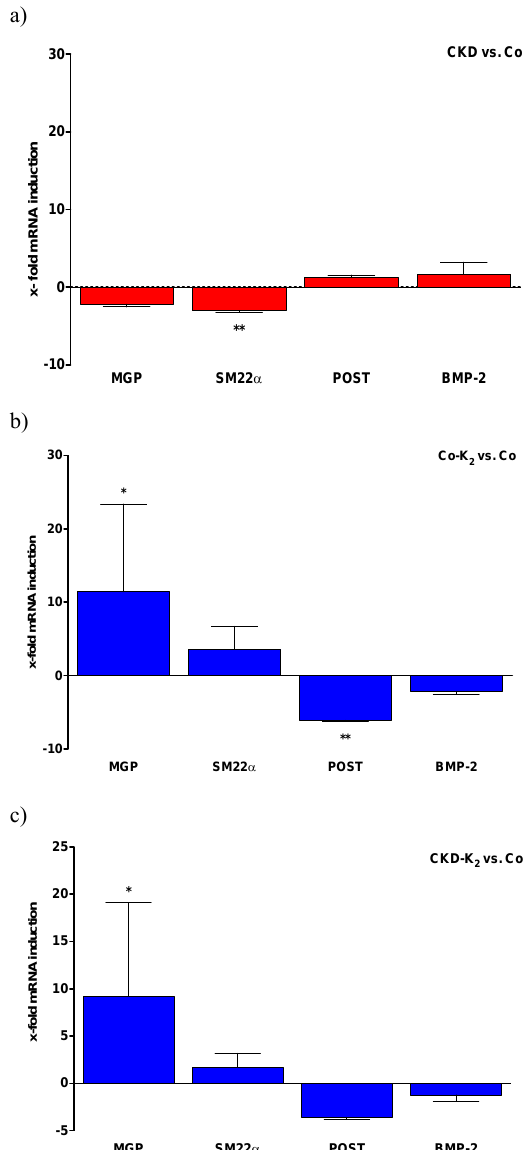
Figure 11. Aortic gene expression. The effect of CKD and MK-7 supplementation on aortic gene expression of calcification modifiers as x-fold induction compared to control group. Red columns depict pro-calcific changes, while alterations associated with potential calcification inhibition are assigned with blue columns. ( a ) In CKD animals SM22 α expression is significantly decreased, whereas MGP expression is non-significantly decreased as compared to Co animals. ( b ) In Co-K 2 animals MGP mRNA concentration is significantly increased, whereas POST mRNA concentration is significantly decreased compared to Co animals. ( c ) In CKD-K 2 animals MGP mRNA concentration is significantly and SM22 α mRNA concentration is tendentially increased compared to Co animals. Co = control group; Co-K 2 = MK-7 supplemented control group; CKD = 5/6 nephrectomized group; CKD-K 2 = MK-7 supplemented 5/6 nephrectomized group; MGP = matrix Gla-protein; POST = periostin; BMP-2 = bone morphogenetic protein 2. Significant differences: * p < 0.05, ** p < 0.01.